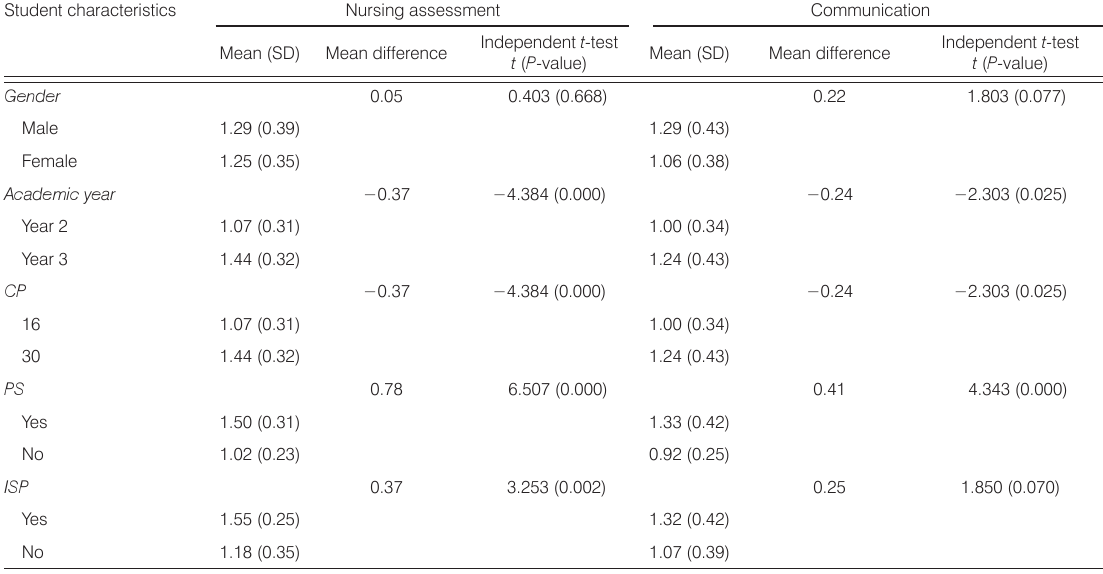
Table 5. Comparison of scores of nursing assessment and communication according to student characteristics.